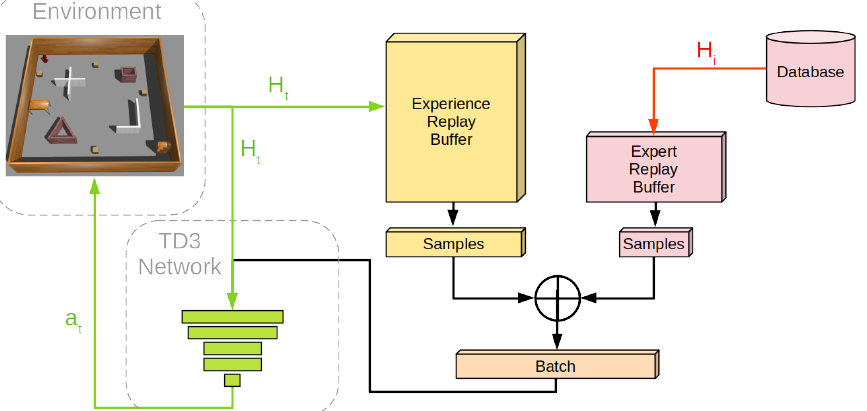
Figure 1. Flowchart of expert experience leveraging in the neural network training process. Red arrows represent actions that happen once during the initialization of neural network learning. Black arrows represent processes happening once every training cycle. Green arrows represent processes taking place during every timestep t of